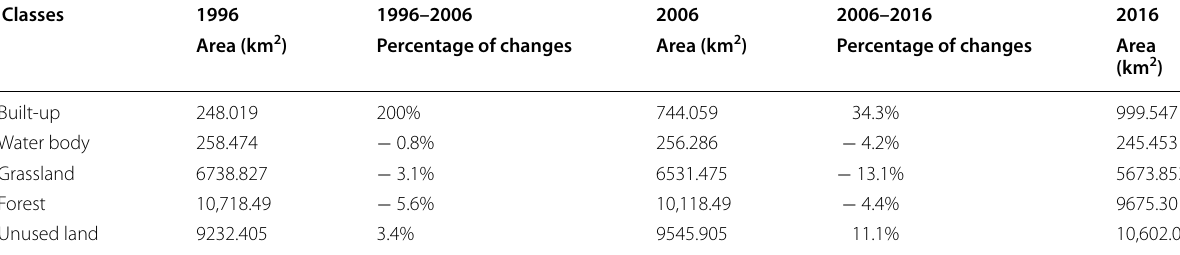
Table 5 Area of land use/cover classes in the city-region of Mazandaran Classes